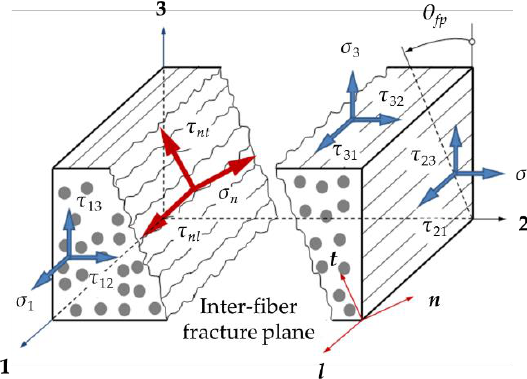
Figure 1. Definition of the material principal coordinate system, 1-2-3, and the fracture plane coordinate system, l - n - t .